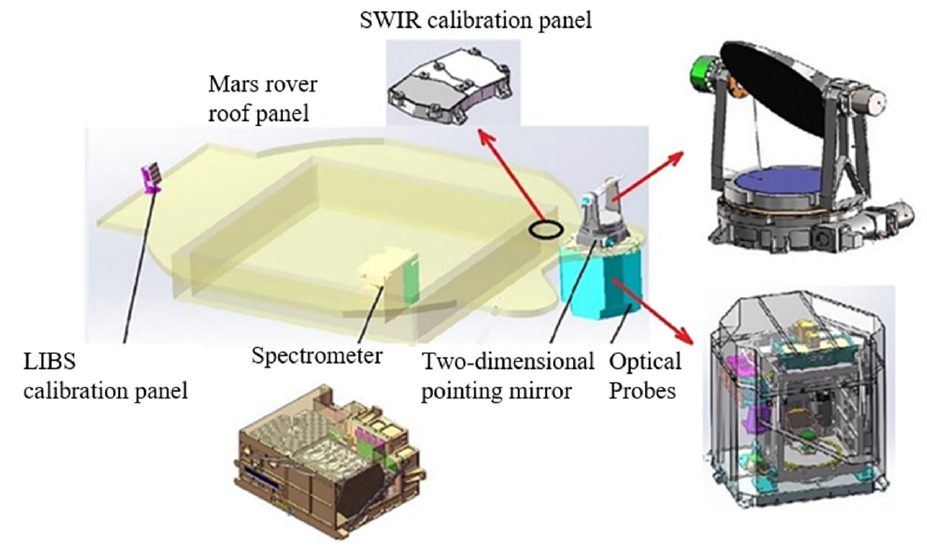
Figure 1. Schematic diagram of MarSCoDe system module distribution [23]. After dark-current subtraction and radiometric correction, the data obtained by the SWIR spectrometer were transformed to radiance by the engineering team. Two calibration references, white and gray panels, were carried by the rover to calibrate the SWIR spectra. The white and gray panels had a reflectivity of 99% and 40%, respectively [3]. The accuracy error of the radiometric calibration of the SWIR spectrometer was less than 5% [3]. The targets were located by the 2D pointing mirror of the MarSCoDe. The field-of-view of the SWIR spectrometer was 36.5 mrad (2.0913 ◦ ). To date, calibration panel and science survey irradiance data have been released for 15 sols; we used these data for data quality evaluation and spectral